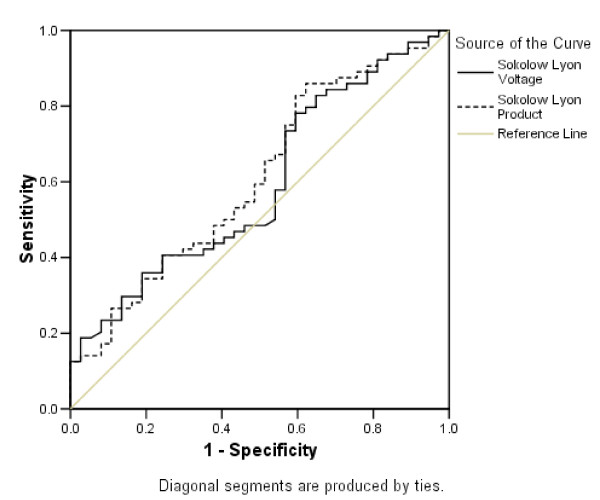
ROC curves with a cut off value of 83 g/m2 for LV hypertrophy.